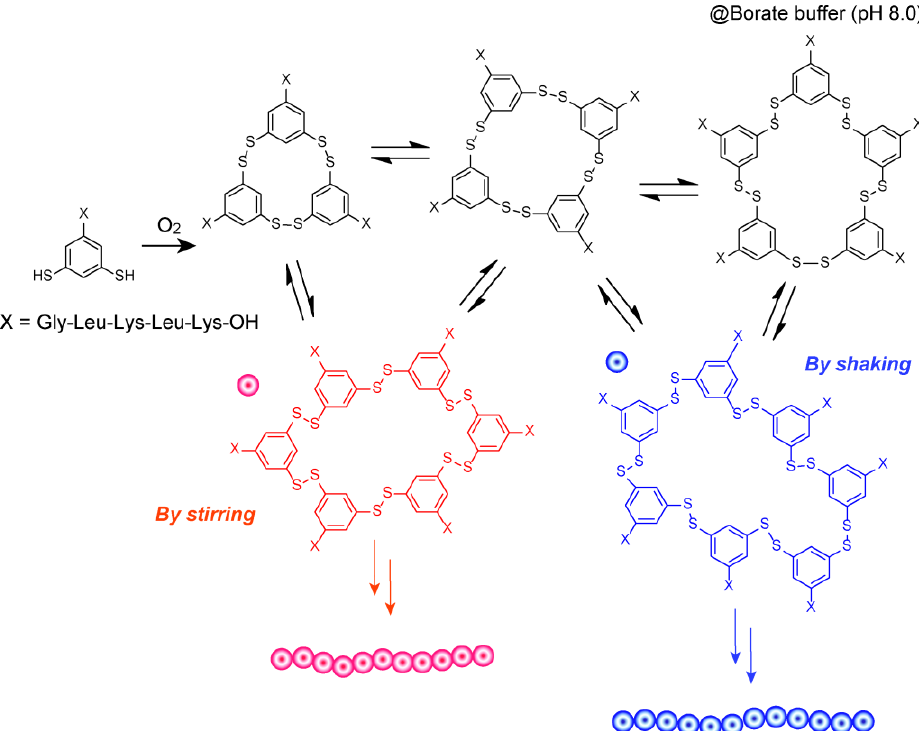
Figure 5. Schematic illustration of production of various macrocycles and elongation of fibers composed of hexamers and heptamers when dithiols with peptide chains were oxidized with stirring or shaking.